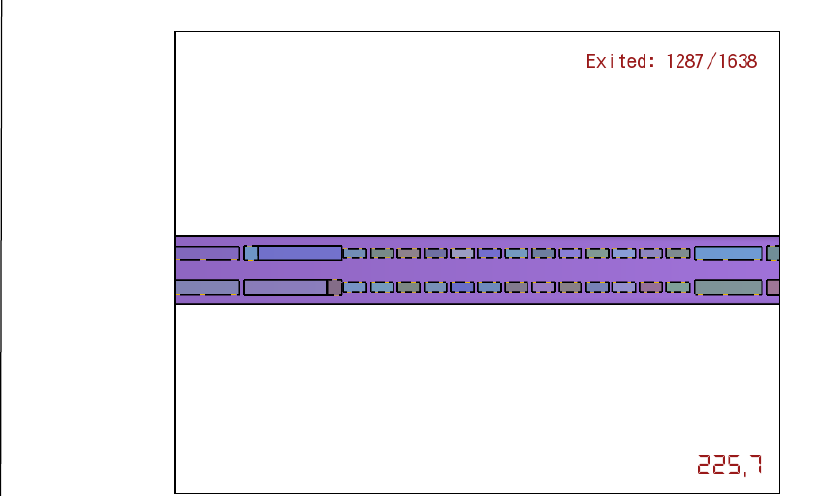
Figure 11 – The simulation example for the noted case after 225.7 seconds from the start of the simulation Рис . 11 – Симуляционный пример приведенного случая спустя 225.7 секунд